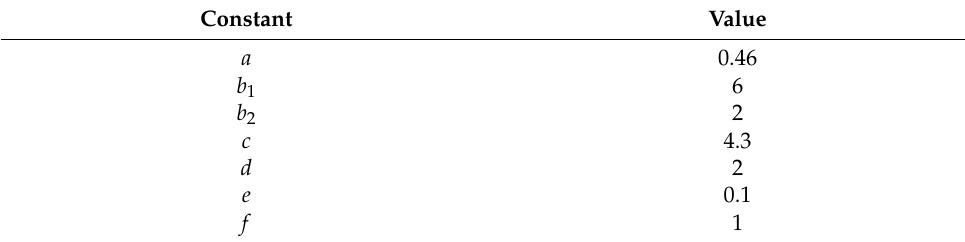
Table 5. Constant values of Equations (1)–(4).